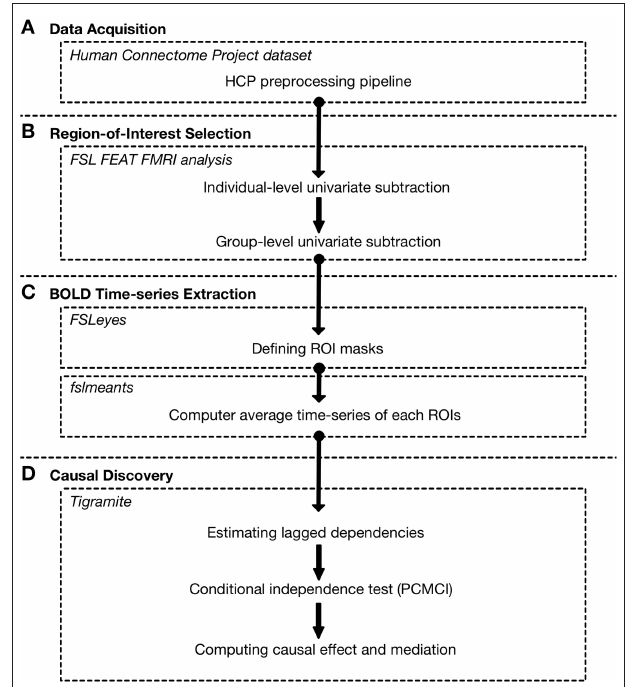
FIGURE 1 | Summary of processing pipeline from fMRI data to connectivity using Tigramite. (A) Here, we use a motor task-fMRI dataset provided by the Human Connectome Project (HCP). The data were pre-processed by the HCP using the HCP pre-processing pipeline (Glasser et al., 2013), which includes image reconstruction, distortion correction, motion correction, and MNI nonlinear volume registration. (B) We performed localization of the activated brain region during the task using FSL FEAT fMRI analysis . Group-level analyses were done using 50 randomly selected individuals. (C) We then defined masks for BOLD time-series extraction based on the aforementioned localization results using FSLeyes . Additional regions that are known to play roles in motor-related function were included. The average BOLD time-series of each region of interest was then extracted using the fslmeants tool. (D) Finally, Tigramite was used to construct a connectivity from the extracted time-series. The first step is to estimate the lagged dependencies to determine the maximum lag ( τ max ). We then performed the conditional independence test to estimate the causal link between each ROI. After that, the estimated time-series graph was used to evaluate the causal effect and causal